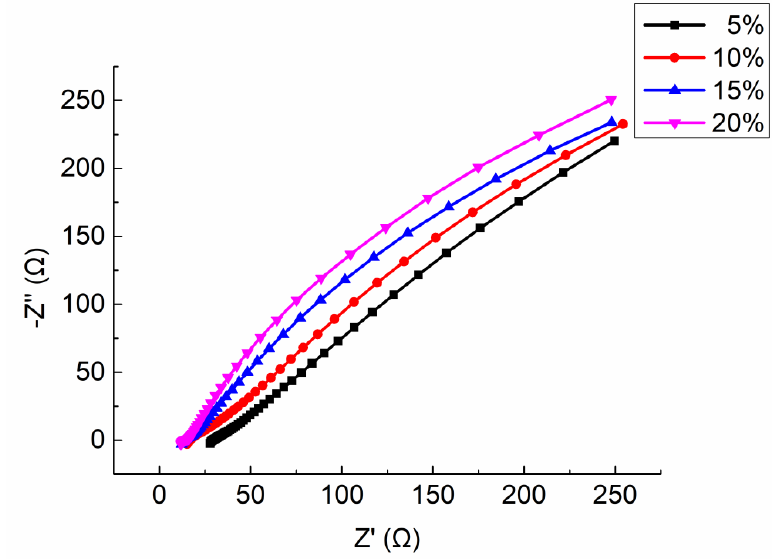
Figure 13. Integrated Nyquist plot of the specimens with different mass ratio of electrolyte solution. Table 9. Parameters of equivalent circuit and resistivity of the specimens with different mass ratio of electrolyte solution.